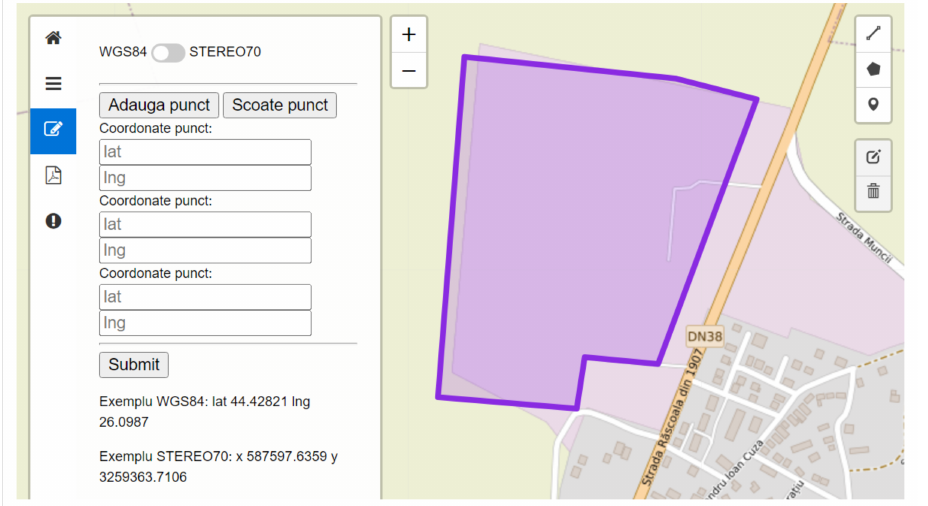
Figure 20. User graphical interface to input coordinates in WGS84 format and map representation. The validated archeological site represented in purple